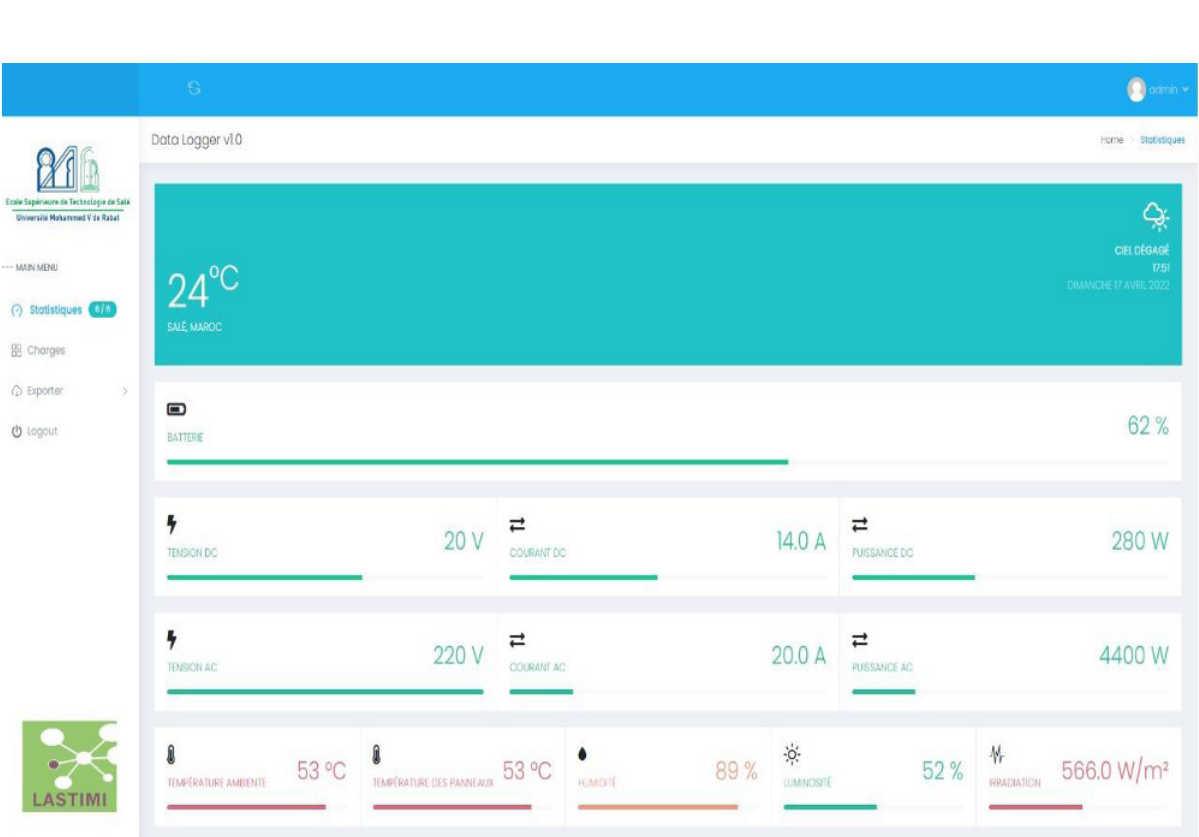
Fig. 3 Graphical user